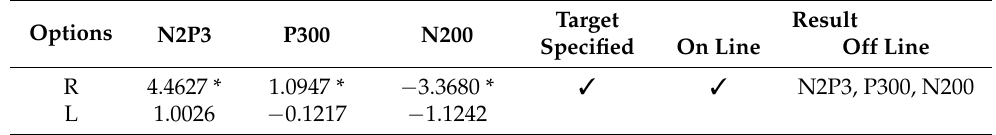
Table 1. ERP values ( µ V) of options obtained from the Cz, 2nd stage, the 4st test run of N04. Target Result Options N2P3 P300 N200 Specified On Line Off Line R 4.4627 * 1.0947 * − 3.3680 *